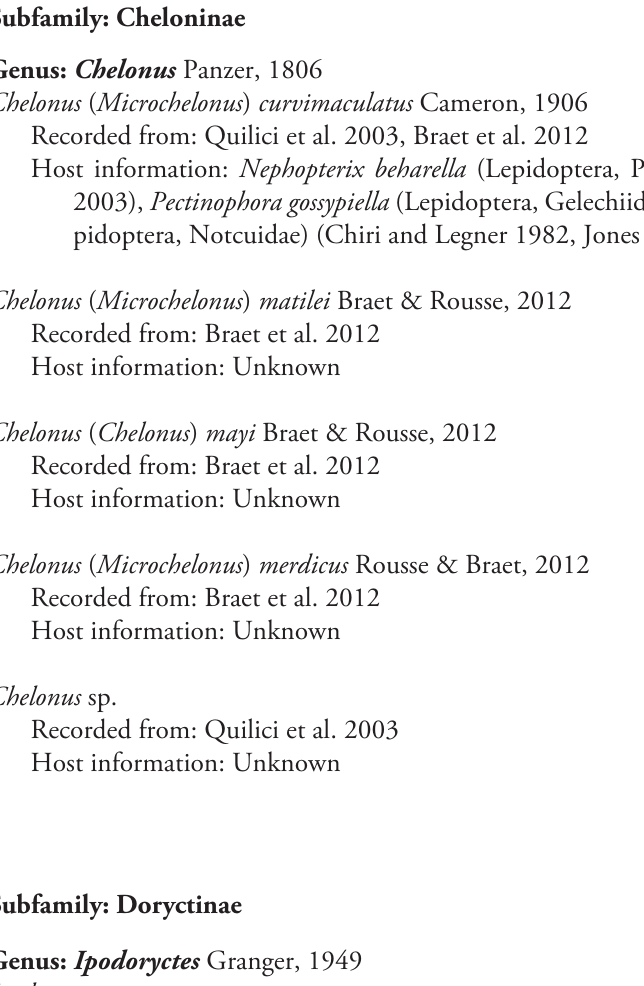
Subfamily: Doryctinae Genus: Ipodoryctes Granger, 1949 Ipodoryctes sp. Host information: Parasitoid of xylophagus and stem-boring Coleoptera (Be- yarslan 2015)